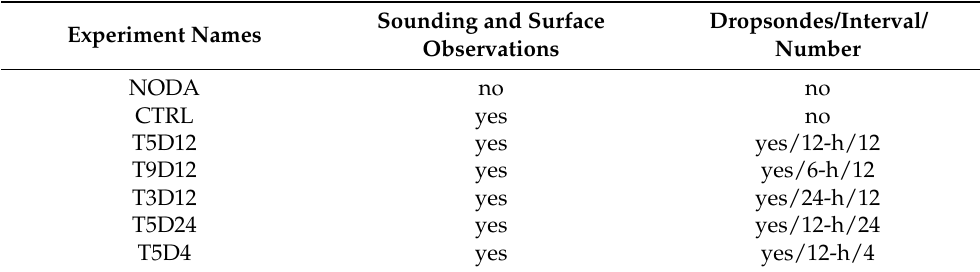
Table 1. The design of the experimental runs, including their names and the data (sounding, surface, and dropsonde observations) that were assimilated during the ETKF DA process. T9, T5, and T3 represent 9, 5, and 3 DA times of synthetic dropsonde data, respectively, with 6-h, 12-h, and 24-h DA intervals. D12, D24, and D4 denote 12, 24, and 4 dropsondes over the northern SCS, respectively. Sounding and Surface Experiment Names Observations